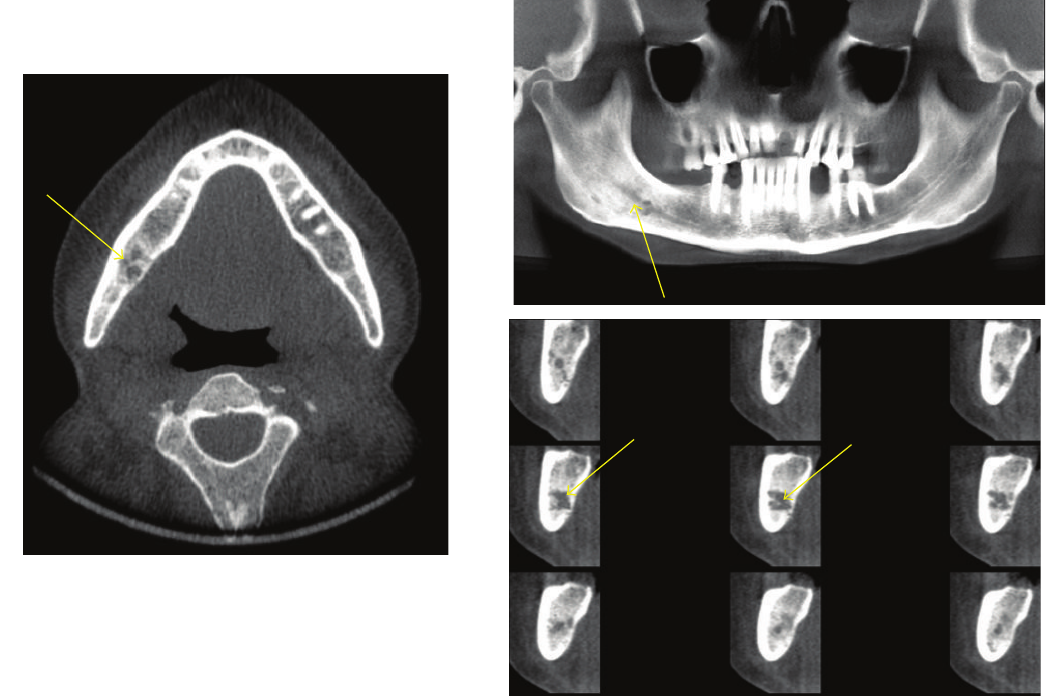
Figure 10: A metastatic lesion seen as multiple poorly defined radiolucent areas (arrows) in the right side of the mandible causing loss of the cortical borders of the right inferior alveolar canal on these axial, panoramic, and orthoradial